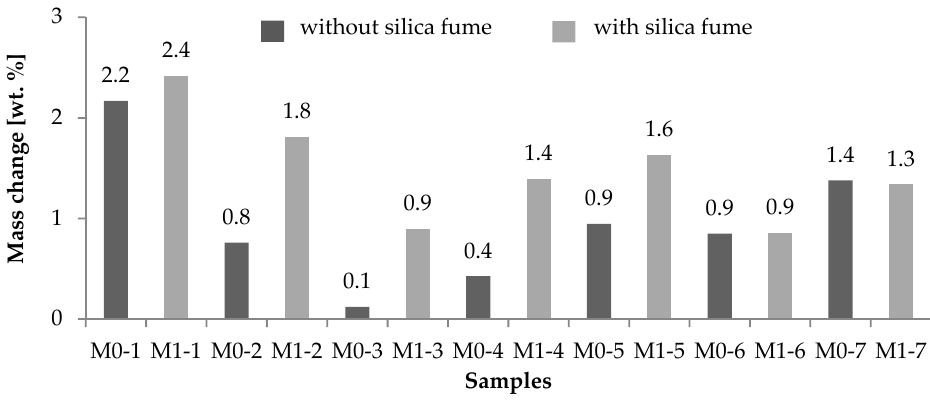
Figure 6. Mass changes of concrete samples.